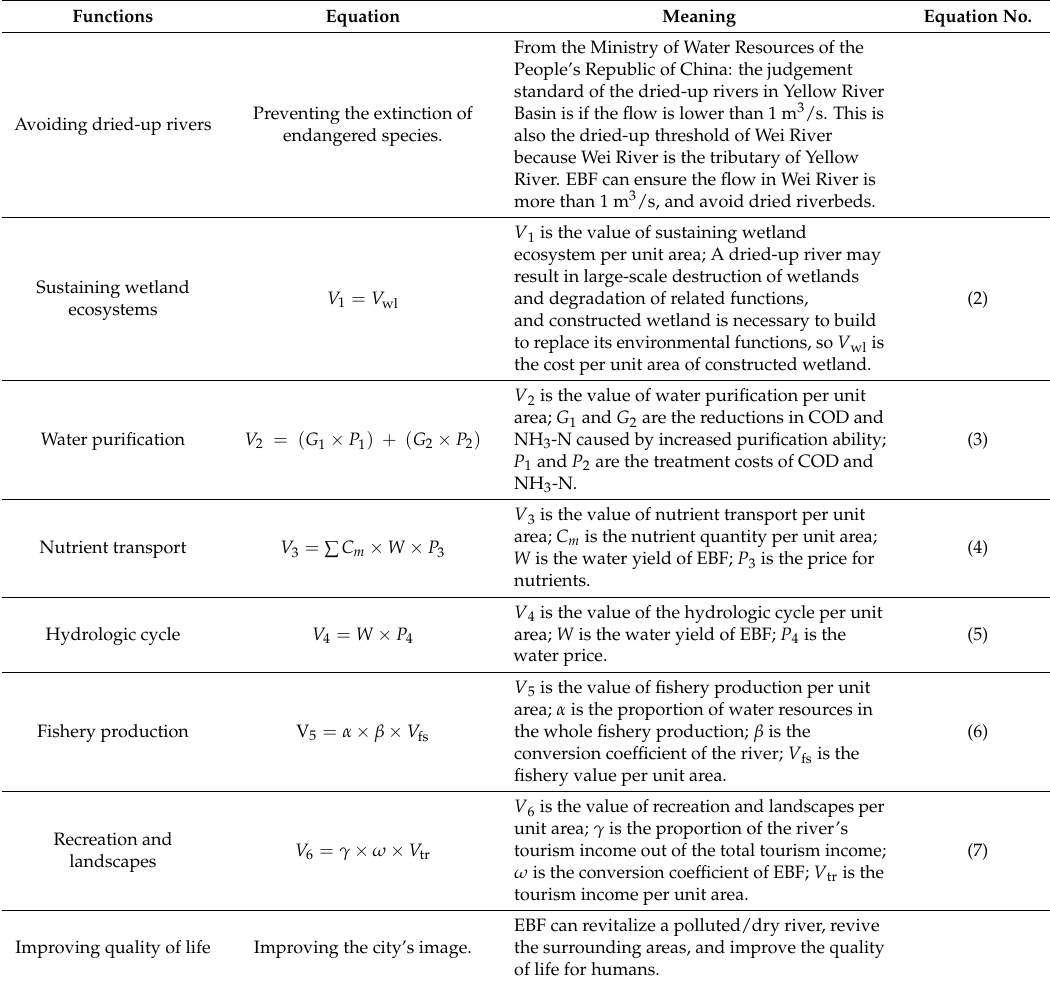
Table 2. The function value of EBF in the dry season. The functions in the non-dry season were not included